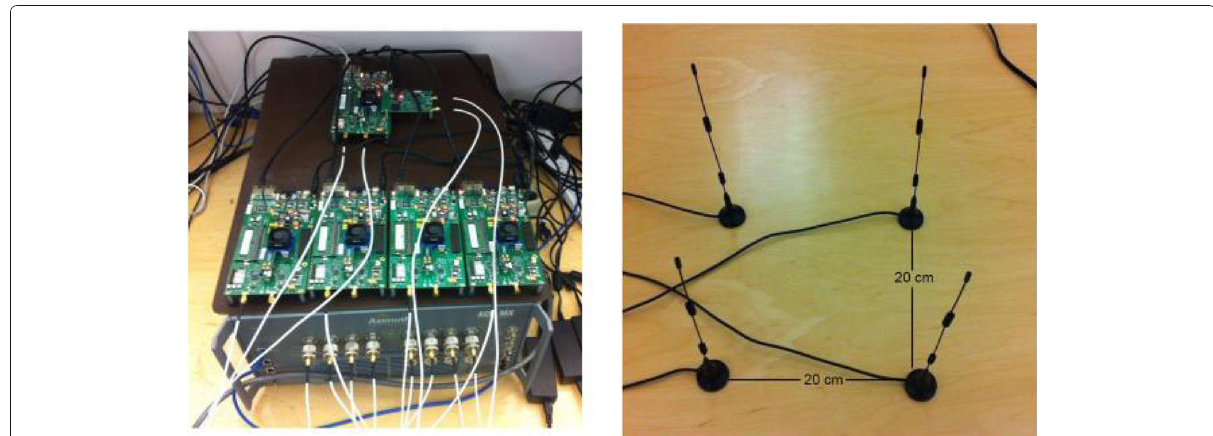
Fig. 9 Equipment settings for performance evaluation. a Setup using WARP and Azimuth Channel Emulator. b Antenna placement for indoor over-the-air testing